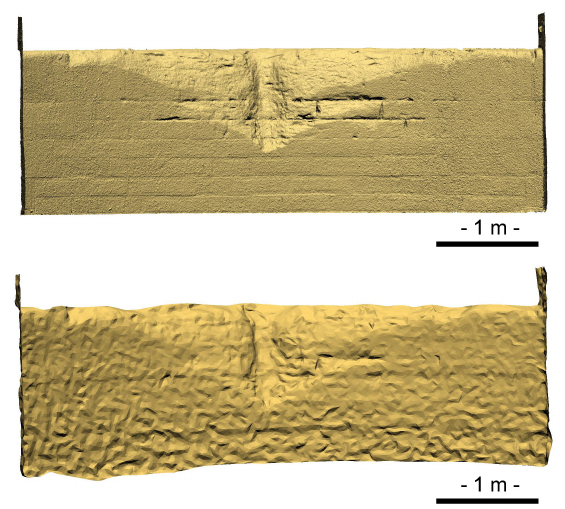
Figure 13. Front views of the threshold wall obtained from TLS (top) and MSS (bottom) scans taken from the floor of the